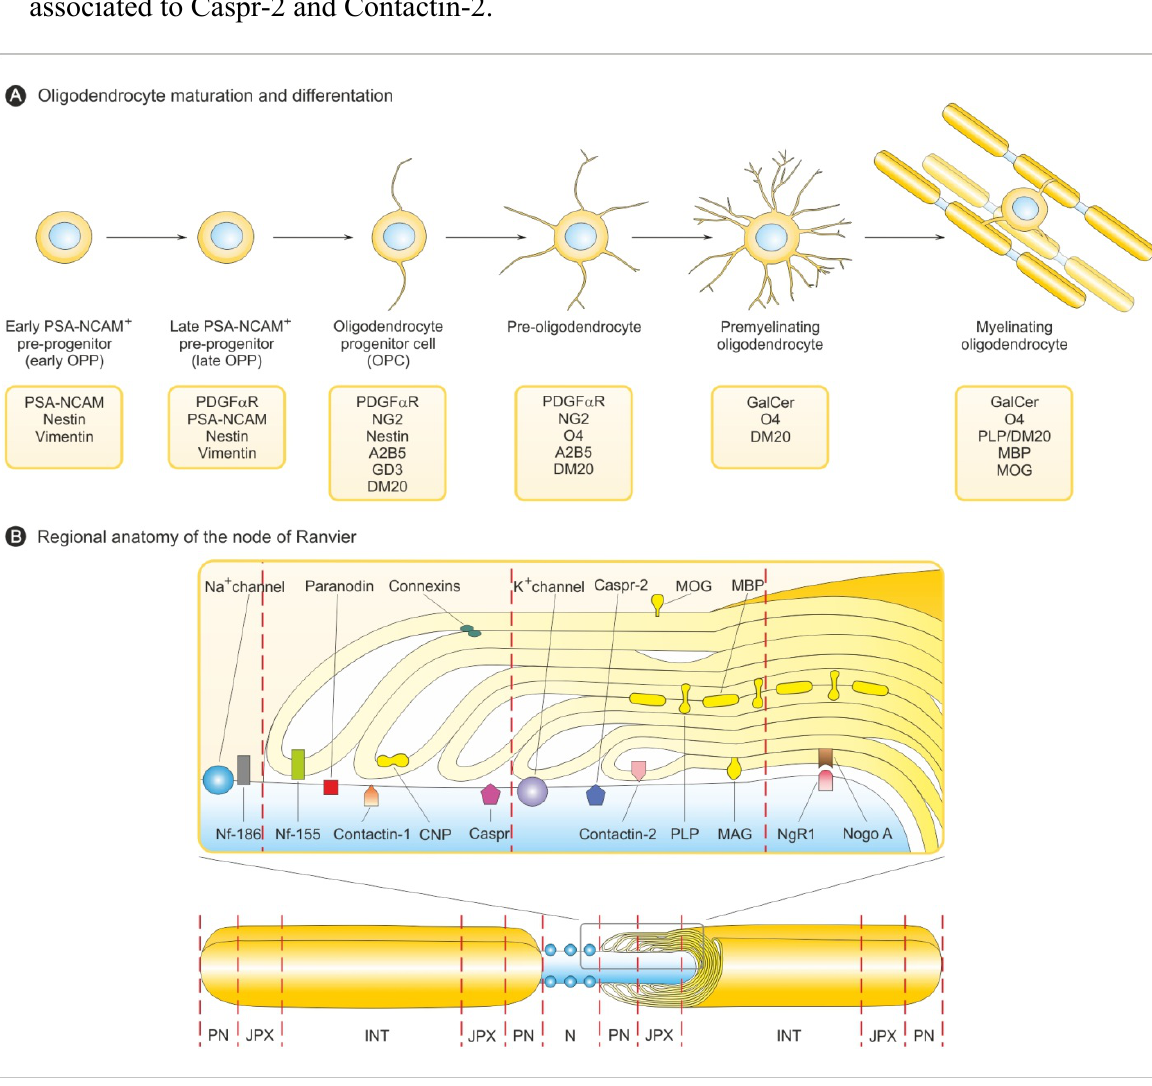
Figure 2. Features of the myelination process. ( A ) Sequential stages of oligodendrocyte